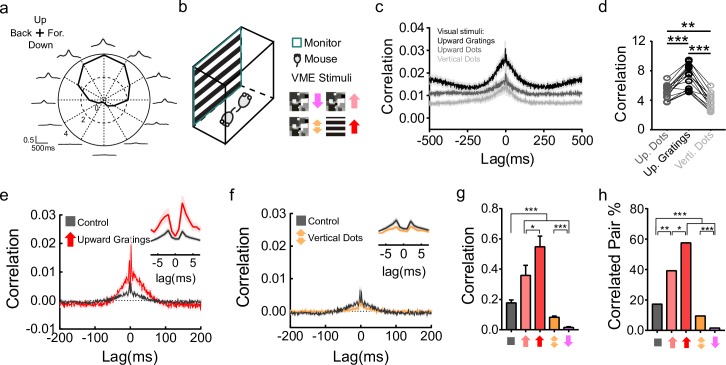
Correlated activity underlies VME-induced changes in ooDSGCs.(a) Polar plot and cross-correlograms showing levels of correlated activity (averaged across V-DSGC pairs) induced by different directions of motion stimuli. Upward motion induces the highest spike time correlation; downward motion induces almost no spike time correlation among V-DSGCs. Stimulus: the same stimulus as used for upward and downward dots VME, except also with motion in 10 other directions. Cross-correlation calculation was done with a 25-ms time bin. Stimulus effect is not removed. (b) Illustration of the VME stimuli that induce different levels of correlated activity. For each stimulus, left, spatial pattern; right, color code with direction of motion. (c) Spike time cross-correlograms under three different visual stimuli: upward gratings (red), upward dots (pink), and vertical dots (orange). Solid lines, average cross-correlograms; shade areas, ±SEM. Only cross-correlograms for V-DSGC pairs are included. Note the cross-correlograms shown here intentionally do not remove the effect of the stimuli, to best represent the amount of difference in total correlated activity elicited by these stimuli. (d) Comparison of total correlated activity evoked by three visual stimuli shown in (c). Correlation is computed as described in 2d. n = 16 pairs; ***p < 0.001, **p < 0.01, paired t test. (e,f) Average cross-correlogram of V-DSGC pairs after VME training with upward gratings (e) and vertical dots (f). Cross-correlograms of all V-DSGC pairs are averaged. Responses used to calculate the cross-correlograms were recorded during travelling gratings. Control, gray, n = 139; upward VME, red, n = 33; vertical VME, orange, n = 253; shaded areas, ±SEM. Insets are close-up views with 1-ms bin size. (g) Quantification of correlation strength from cross-correlograms in 2b, 3e, and 3f. Correlation is computed as described in 2d. *p < 0.05, ***p < 0.001, unpaired t test. Error bars, SEM. (h) Proportion of V-DSGC pairs with measurable gap junction connections. The proportions of correlated pairs in all V-DSGC pairs show significant difference, with upward VMEs higher than control and vertical VME lower than control (chi-squared test, ***p < 0.001; **p < 0.01). In addition, the upward gratings VME is significantly higher than upward dots VME (chi-squared test, *p < 0.05). Data for this figure are in S3 Data. ooDSGC, ON-OFF direction selective ganglion cell; VME, visual motion experience.